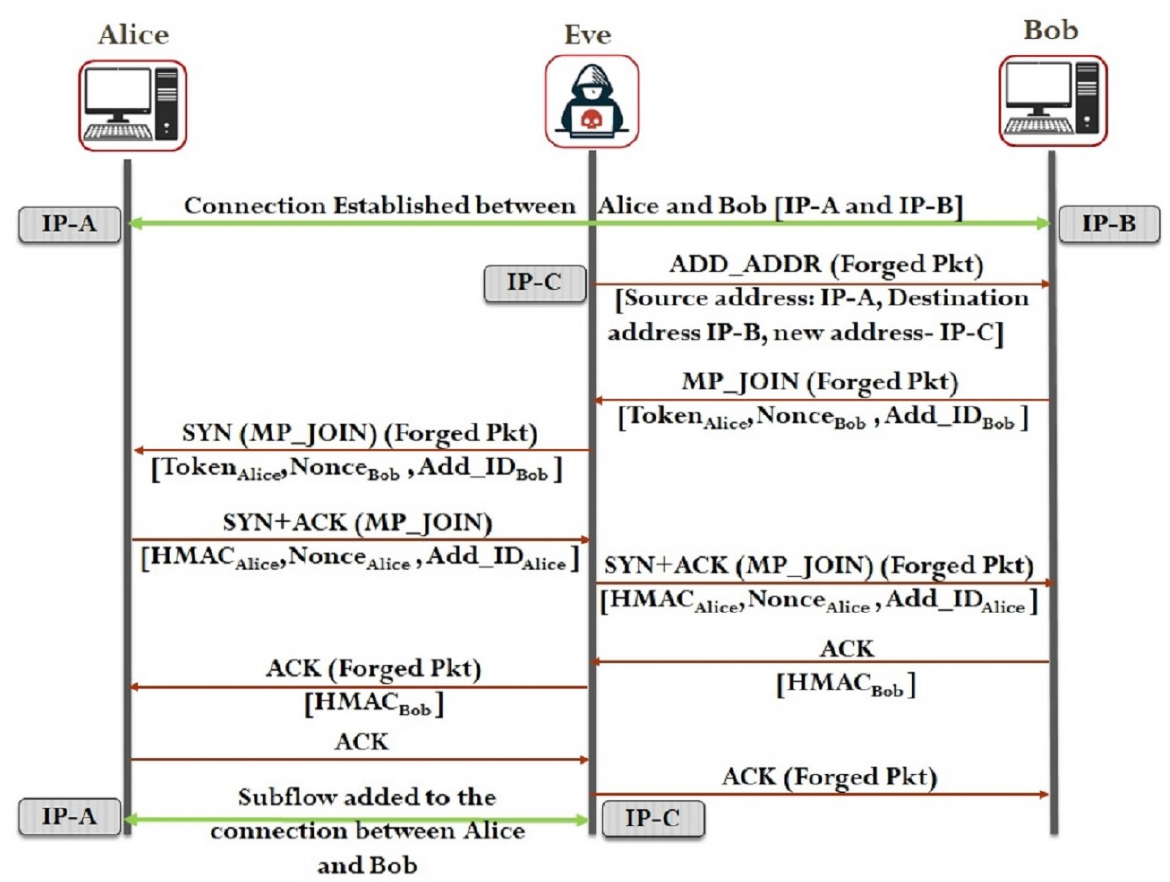
Figure 7. Use of ADD_ADDR vulnerability to initiate the attack to compromise the connection.